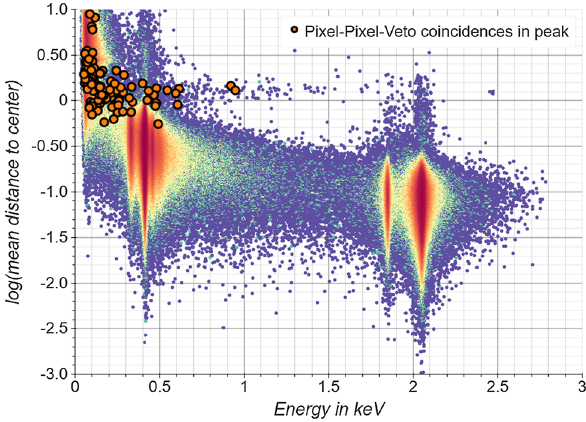
Fig. 12 The logarithm of the mean distance to the ellipses’ centers against E Filter . The orange dots are the muon veto coincidences, which are in addition coincident to other pixel events, located in a band around meandistance=1.PulsesduetotheECin 163 Hoshowsmallerdistances 163 Ho are well visible, the M-lines around 2 keV and the